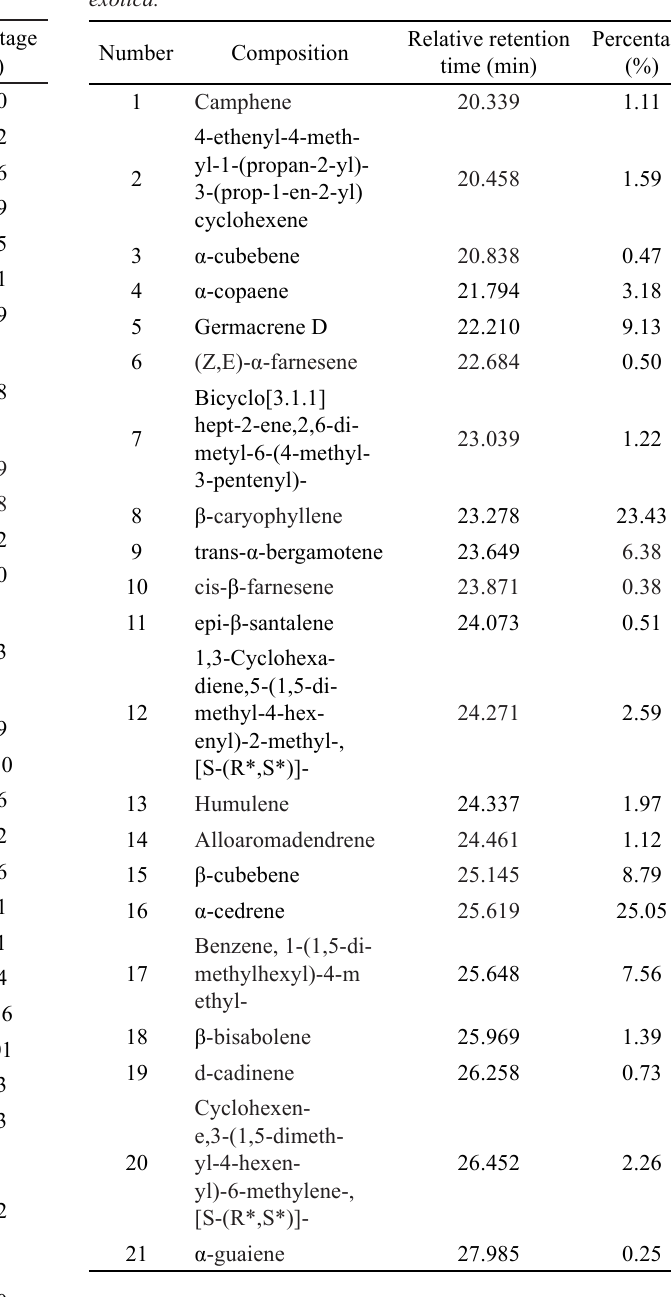
Table 7. Chemical compositions from mashed fallen leaves of M. exotica